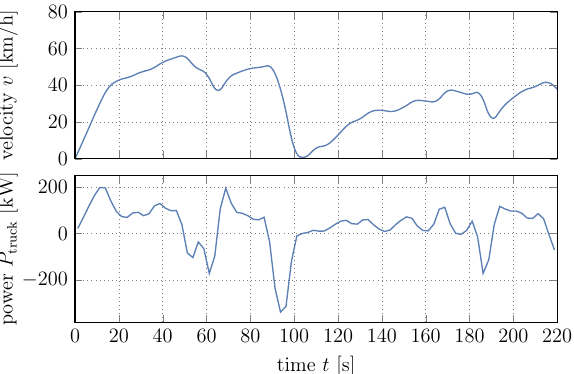
Figure 6. Velocity profile and corresponding power needed to accelerate or decelerate the truck. On the left, in Figure 7 the key variables of the system with the baseline strategy are shown. At the top of the picture the displacement factor γ can be seen, which varies almost only between its extreme values, so that propulsion can immediately be fully supported and the maximum amount of braking energy can be stored. The drive support always lasts until the gas pressure p 1 has reached its minimum value, as seen below, which corresponds to the minimum amount of hydraulic fluid within the accumulator, and hence an empty energy storage. Overall, the recuperation system is inactive over very long periods. Underneath, the resulting power distribution between the hydraulic unit and the internal combustion engine is shown, where, again, one can clearly see that the combustion engine is immediately supported as soon as there is energy stored within the bladder accumulator. At the bottom left of Figure 7 the efficiencies of the hydraulic unit η hyd and the combustion engine η comb can be seen. Particularly noteworthy here is that the efficiency of the hydraulic unit at low speeds reaches very low values as can bee seen at around t = 5 s and t = 110 s.